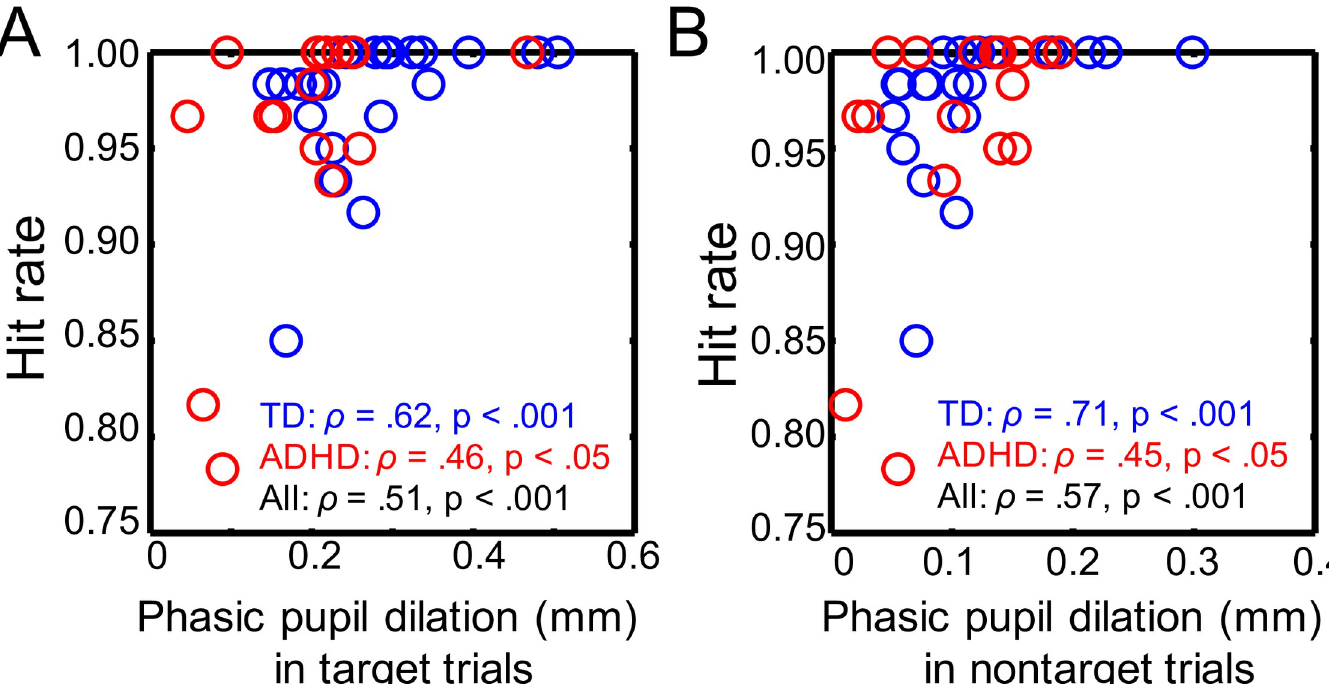
Fig 4. Comparisons of the relationships of task performance with the parameters of pupil diameter between the TD and ADHD groups. Hit rate and phasic pupil dilation in the target trials (A) and in the nontarget trials (B). Hit rate: the probability of correctly detecting a target on target trials.